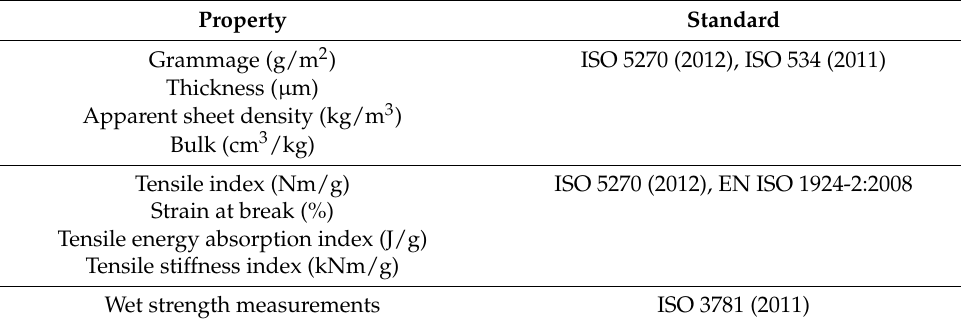
Table 2. Test methods applied for the straw